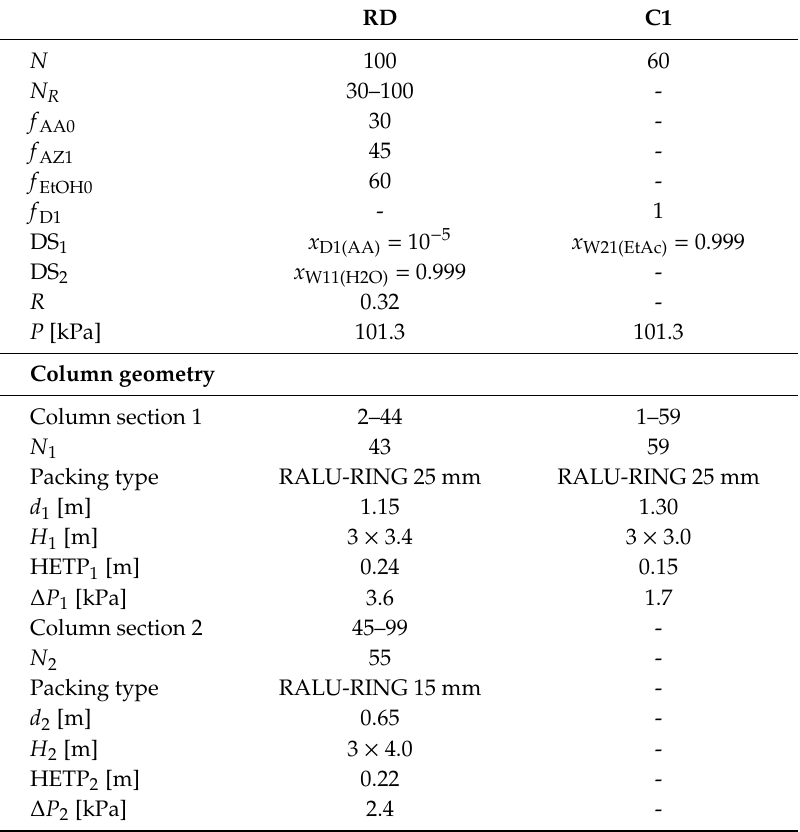
Table 6. Parameters of designed columns—RDS (Figure